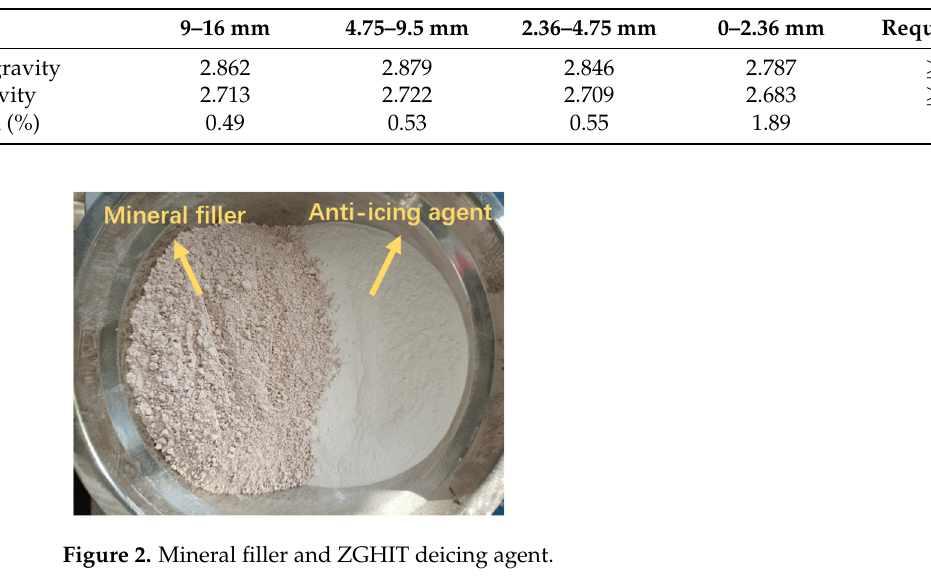
Table 2. Engineering properties of aggregate with different particle sizes.